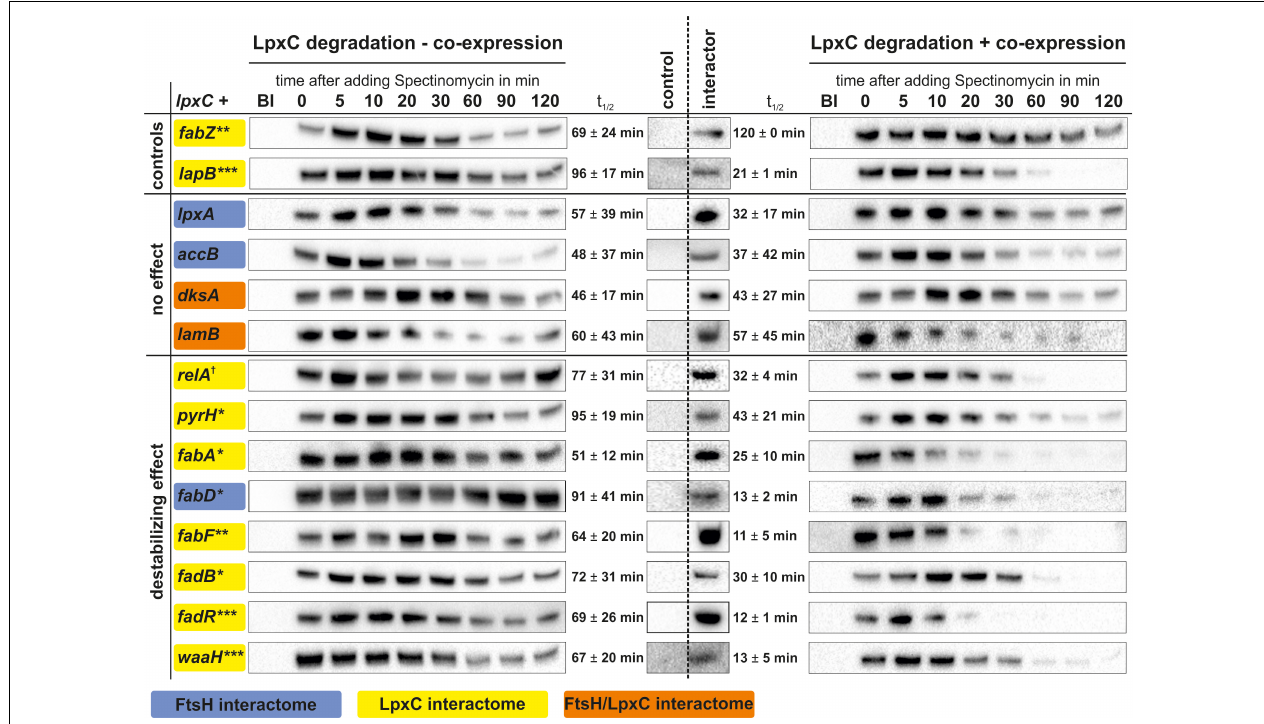
FIGURE 4 | In vivo LpxC degradation experiments using a double expression system for identification of factors influencing LpxC turnover. Expression of lpxC (left) or lpxC and a gene of choice (right) was induced in exponential growth phase and translation was stopped by adding spectinomycin. Samples were taken before (BI) and 0–120 min after stopping translation. Overproduction of putative LpxC interactors compared to the control was verified by SDS-PAGE followed by immunodetection (middle) . After SDS-PAGE and immunodetection LpxC signals were quantified and half-lives calculated. Overexpression of fabZ led to stabilized LpxC (higher LpxC t 1 / 2 after fabZ expression) and lapB to destabilized LpxC (lower LpxC t 1 / 2 after lapB expression) (controls). Gene products, which did not influence LpxC degradation (no effect) and genes which caused rapid LpxC degradation (destabilized effect), are shown. Standard deviations were calculated from at least three biological replicates ( Supplementary Table S4 ). † p ≤ 0.15, ∗ p ≤ 0.10, ∗∗ p ≤ 0.05, ∗∗∗ p ≤